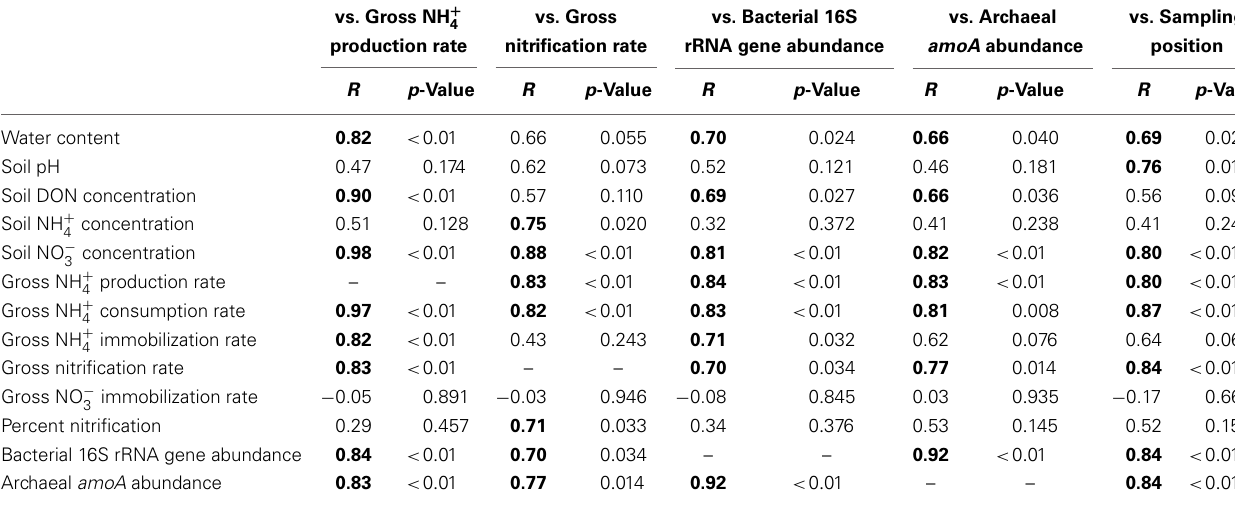
Table 2 | Correlation with gross rates of NH + sampling position.